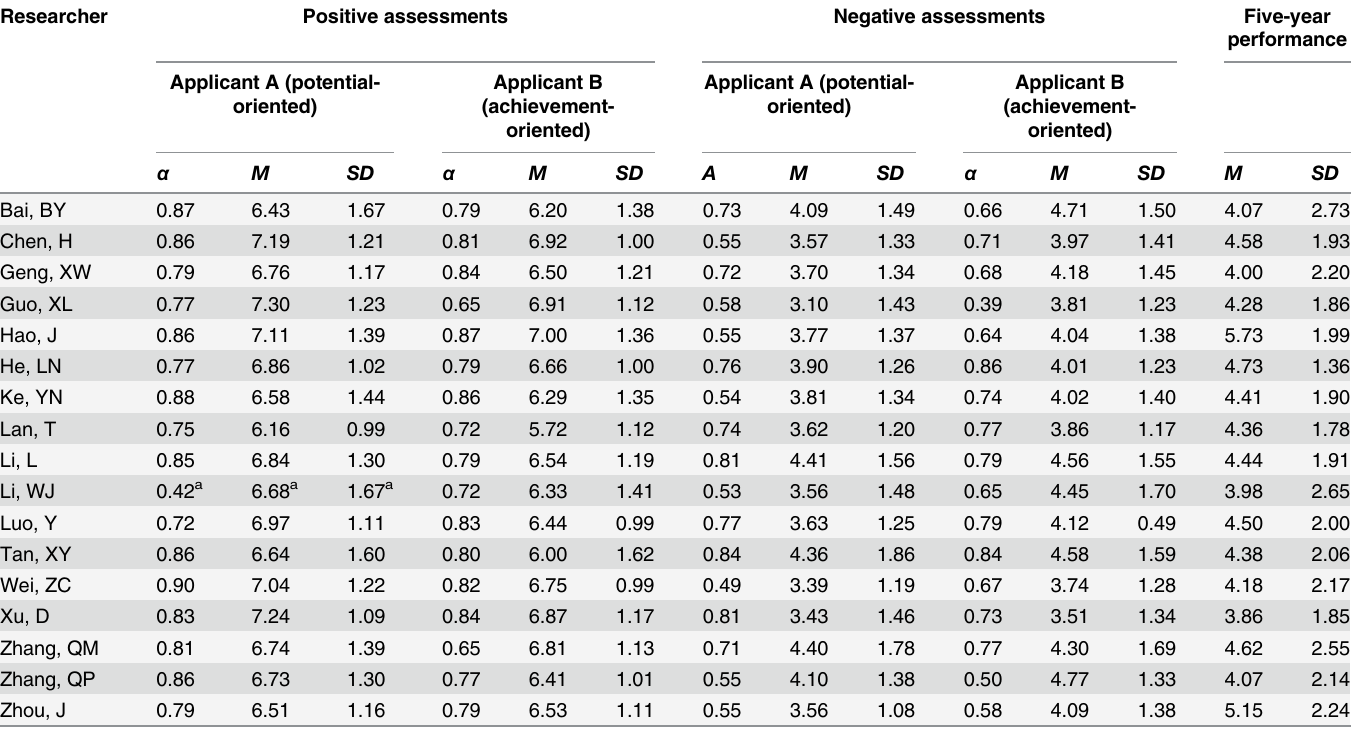
Table 2. Reliability and descriptive statistics of 17 studies on dependent